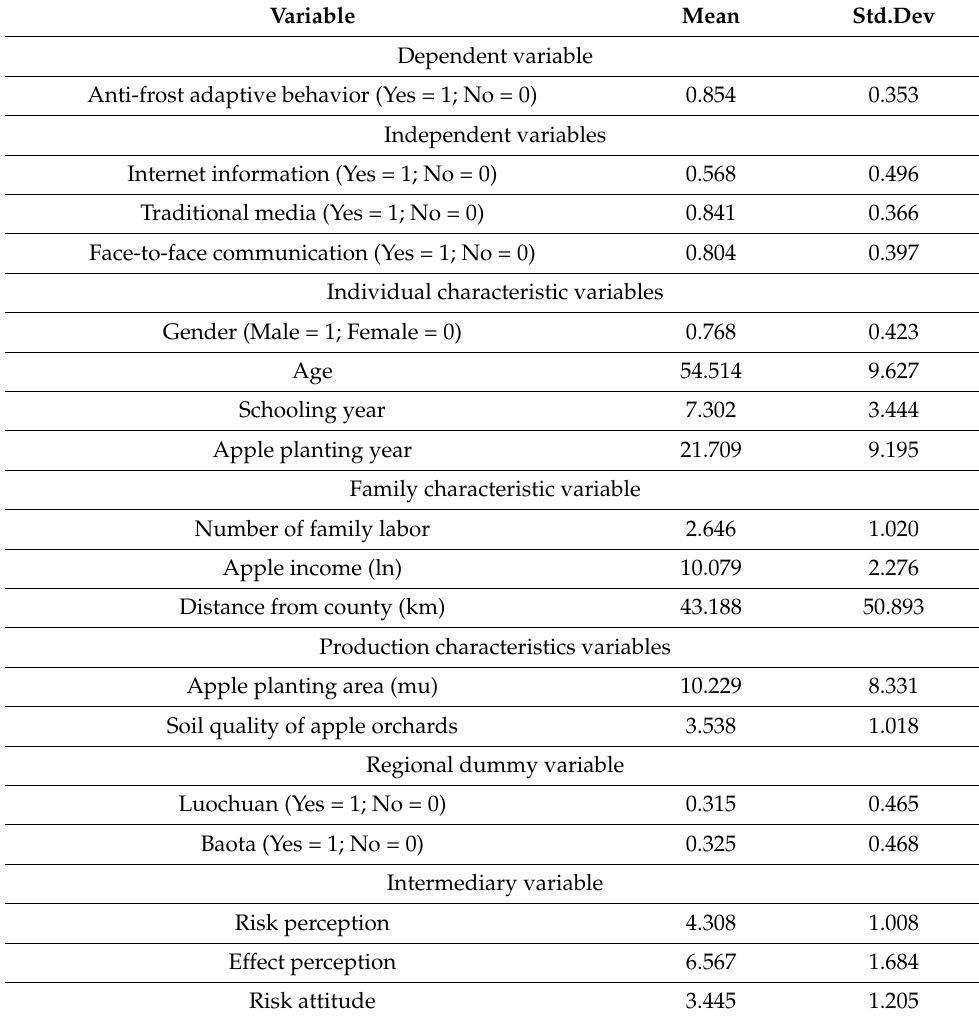
Table 2. Descriptive